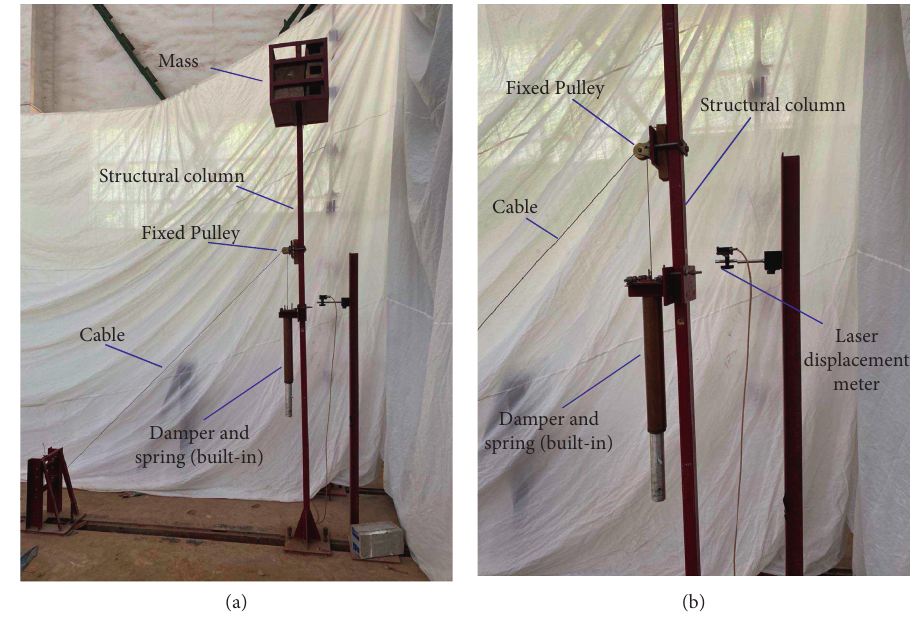
Figure 2: Experiment site photos of high-rise structure and composite damper